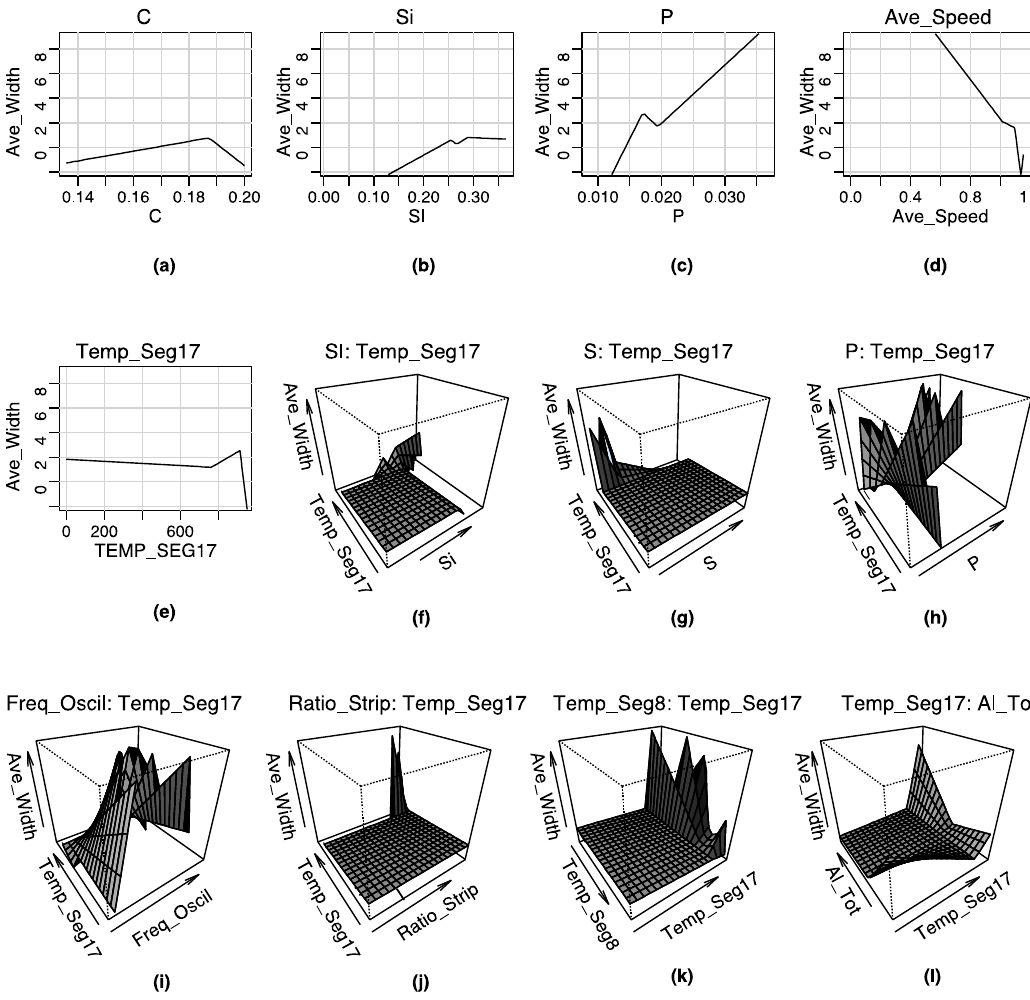
Figure 6. Graphical representation of the terms composing the MARS model for the Average Width of the spots forming the centerline segregation: ( a ) first order term of the predictor variable Carbon content; ( b ) first order term of the predictor variable Si; ( c ) first order term of the variable P; ( d ) first order term of the variable Average Speed; ( e ) first order term of the variable Temp_Seg17; ( f ) second order term of the variables Si and Temp_Seg17; ( g ) second order term of the variables S and Temp_Seg17; ( h ) second order term of the variables P and Temp_Seg17; ( i ) second order term of the variables Freq_Oscillation and Temp_Seg17; (j ) second order term of the variables Ratio_Strip and Temp_Seg17; ( k ) second order term of the variables Temp_Seg8 and Temp_Seg17; ( l ) second order term of the variables Temp_Seg17 and